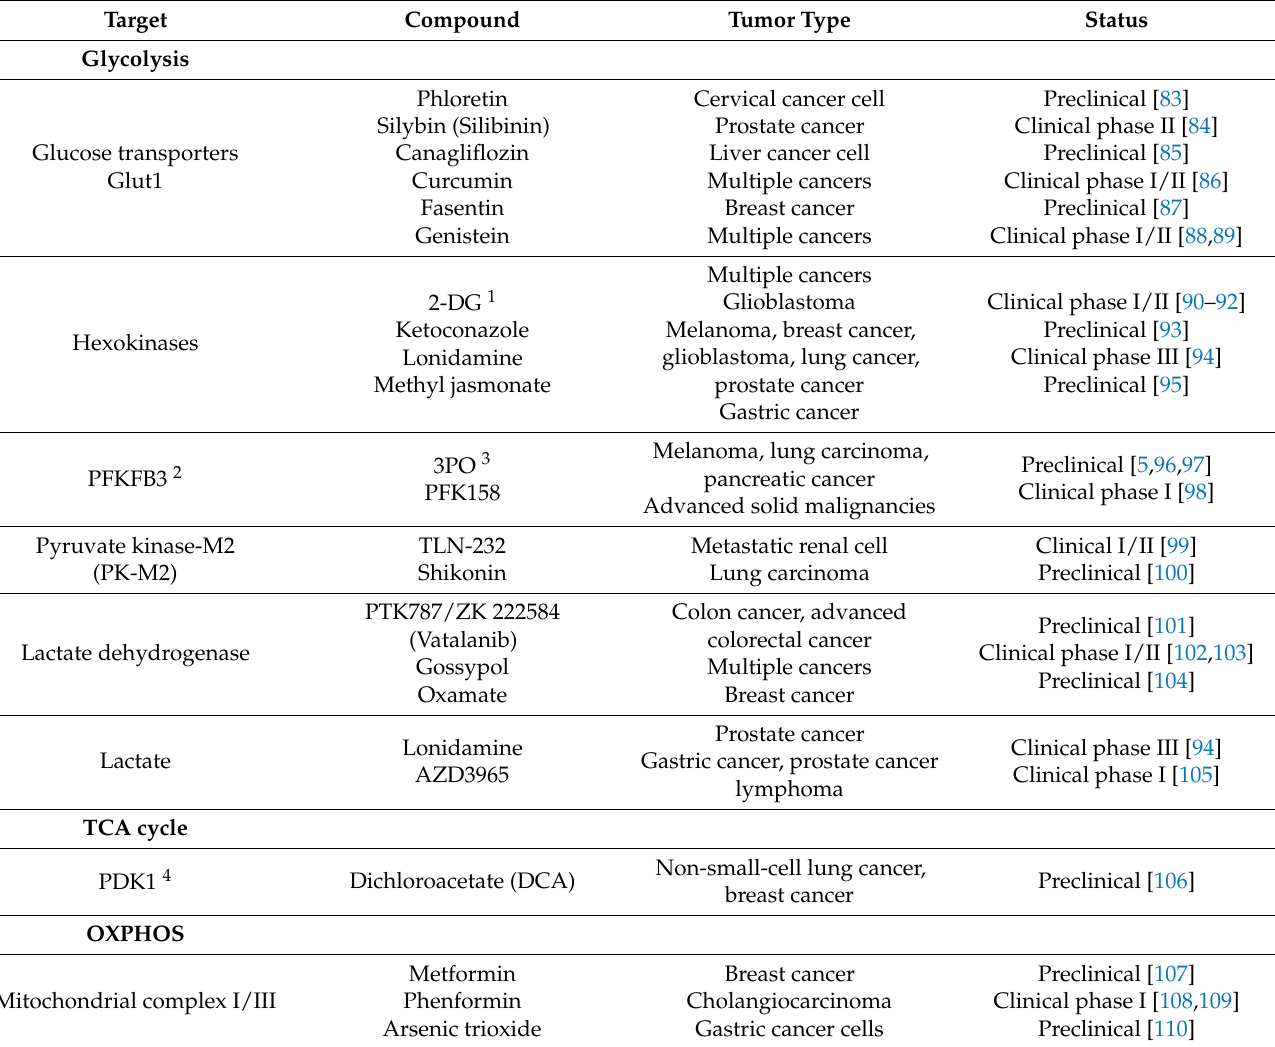
Table 1. Compounds that directly target metabolic enzymes involved in tumor angiogenesis.